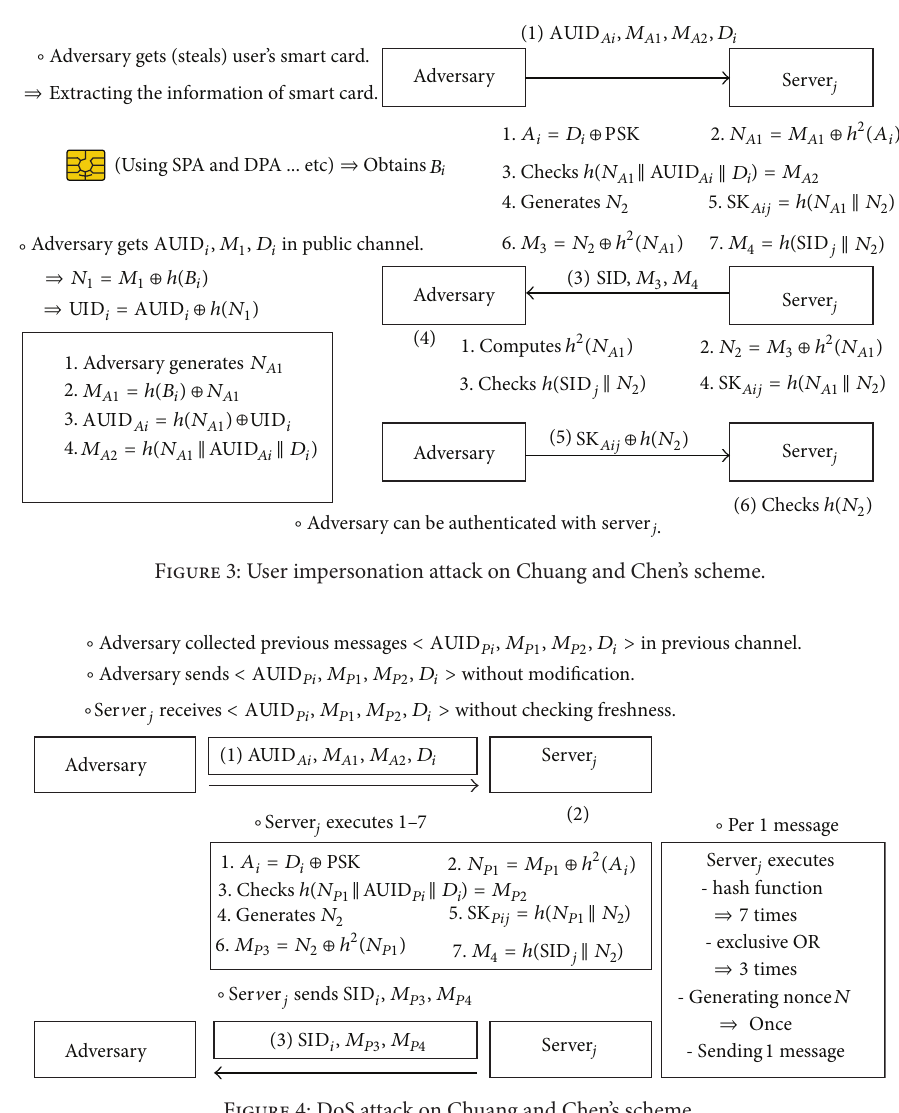
Figure 4: DoS attack on Chuang and Chen’s